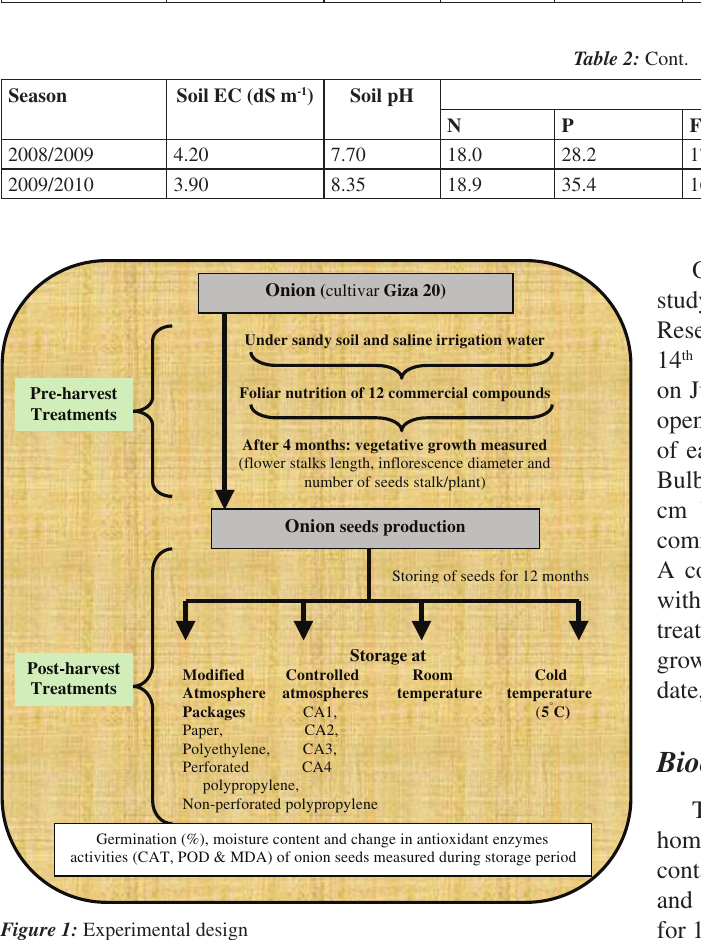
Figure 1: Experimental